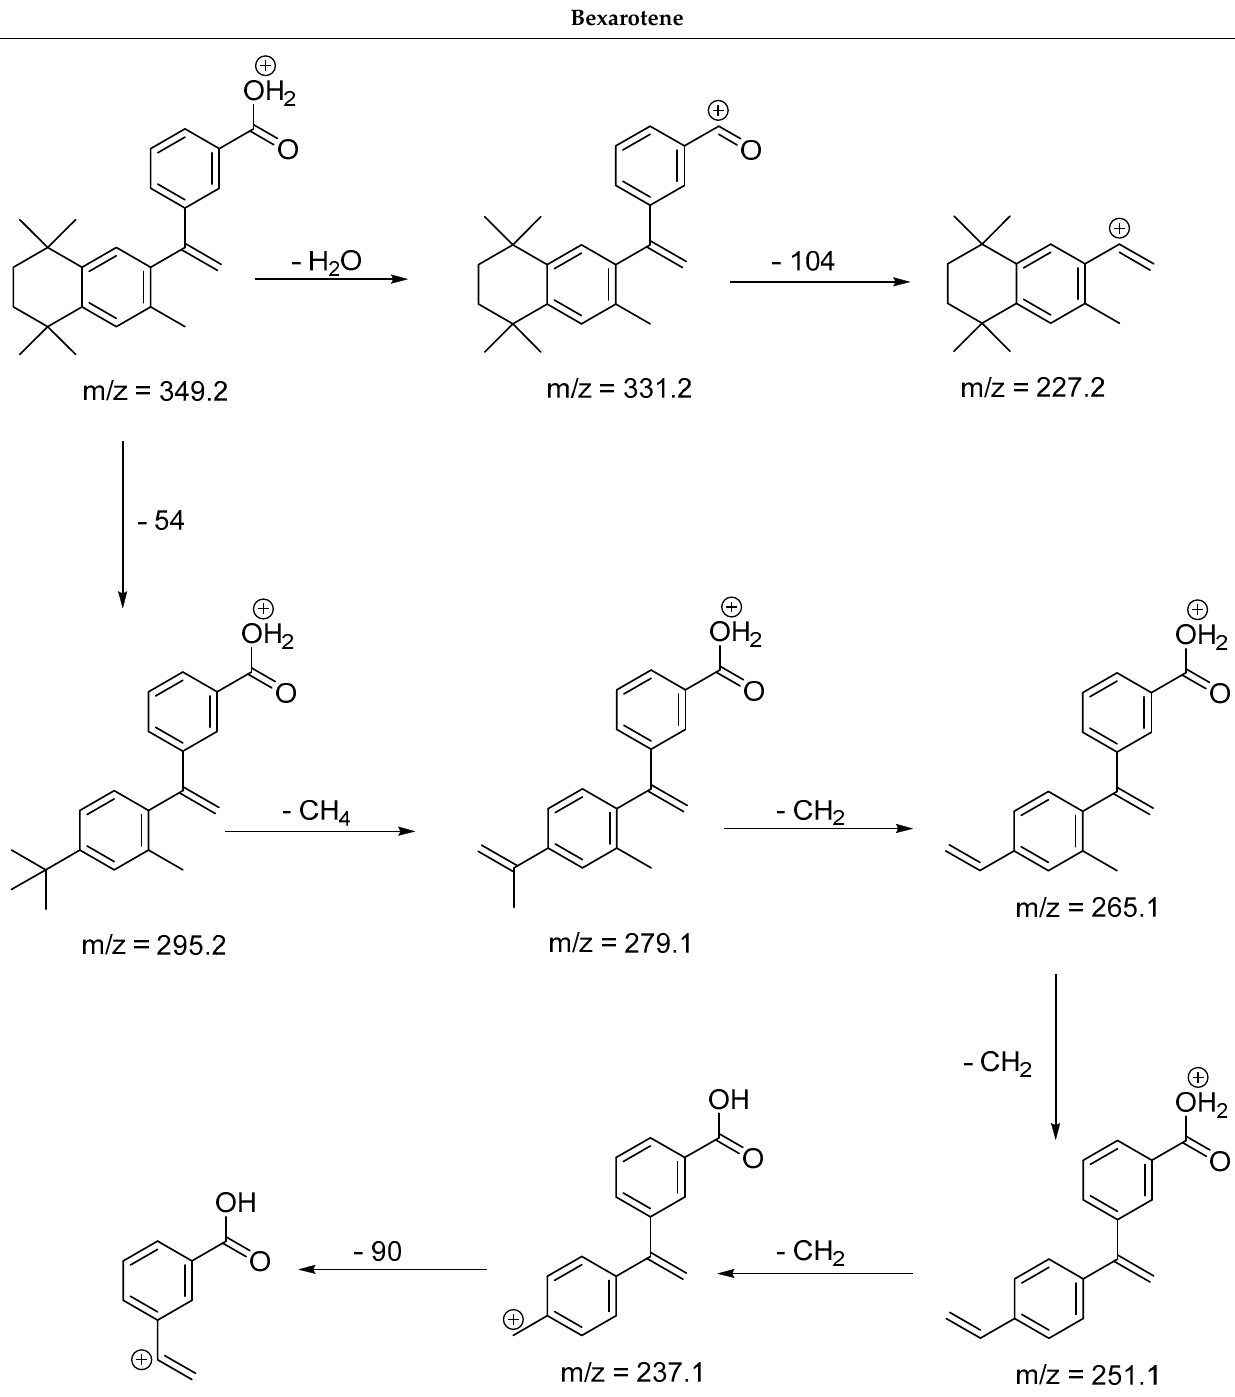
Table 2. Proposed fragmentation patterns.